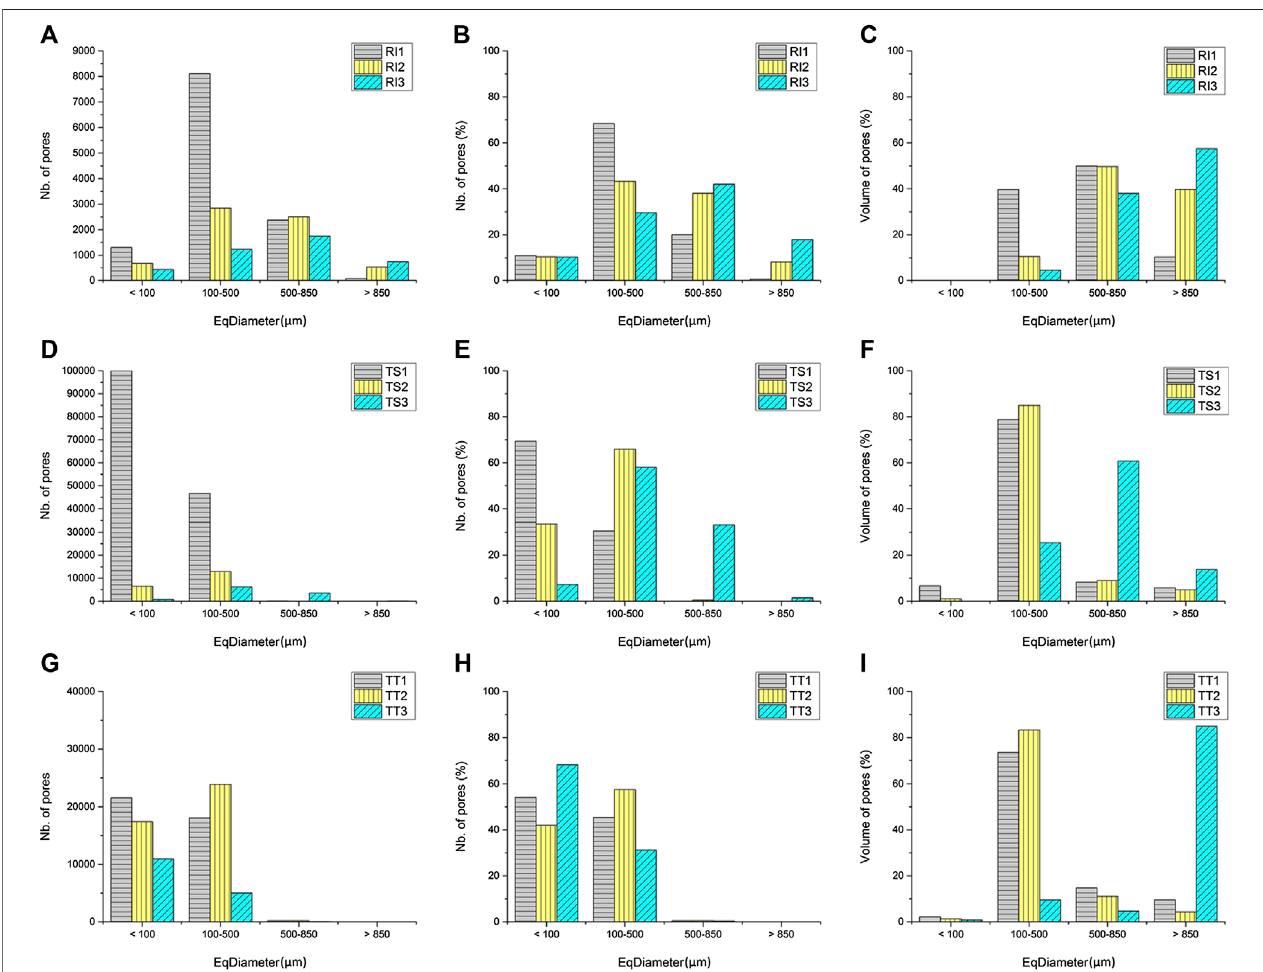
FIGURE 7 | Graphical representation of the pore size distribution of the analyzed alkali-activated foams cured at 70 ° C (RI, TS, and TT fl y ash used, 1, 2, and 3 represent the amount of foaming and stabilizing agents used; (A) – (C) RI fl y ash, (D) – (F) TS fl y ash, (G) – (I) TT fl y ash), determined by means of X-ray micro-tomography. The results present the number, percentage and volume of pores with respect to pore size diameter (EqDiameter).